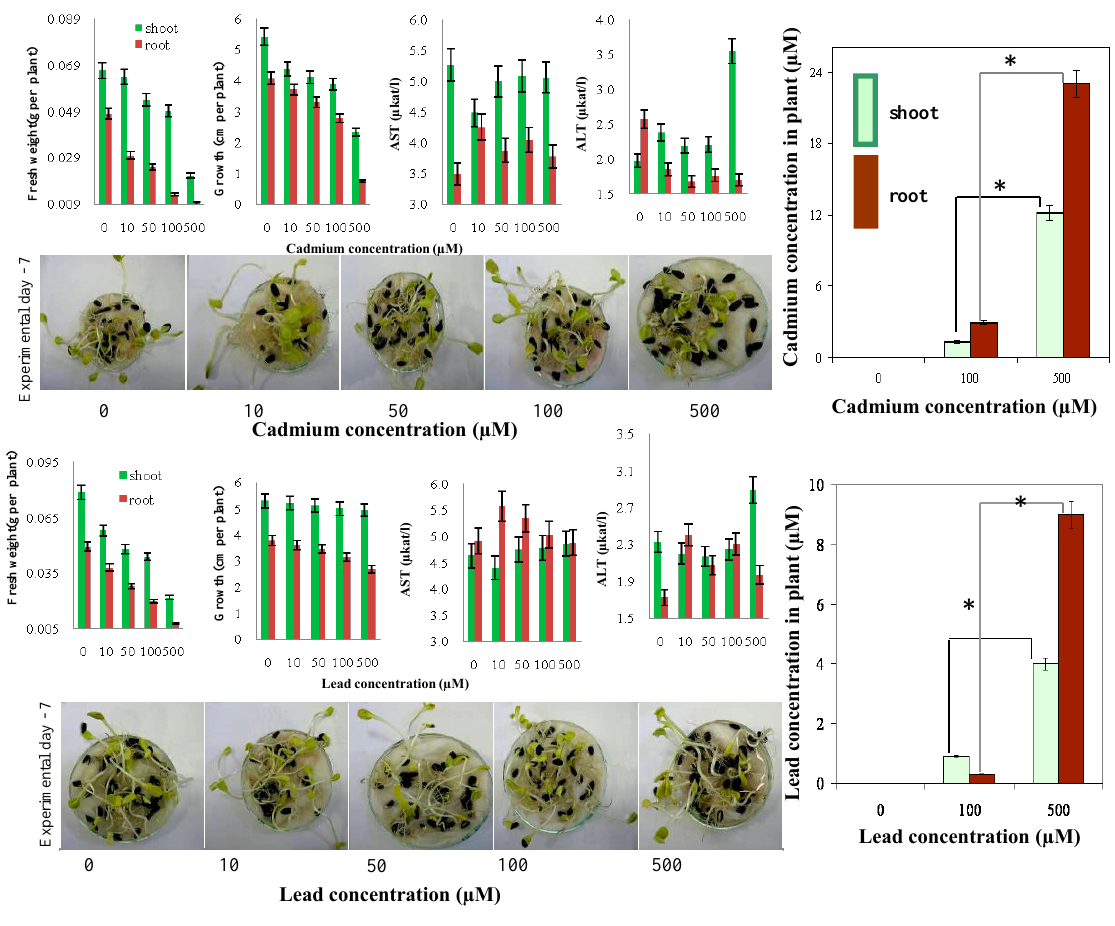
Figure 7. Sunflower seedlings. Changes in fresh weight, growth, AST and ALT activities in sunflower seedlings treated with (A) cadmium(II) ions and/or (B) lead(II) ions. Content of (C) cadmium(II) ions and /or (D) lead(II) ions in shoots and roots of the treated